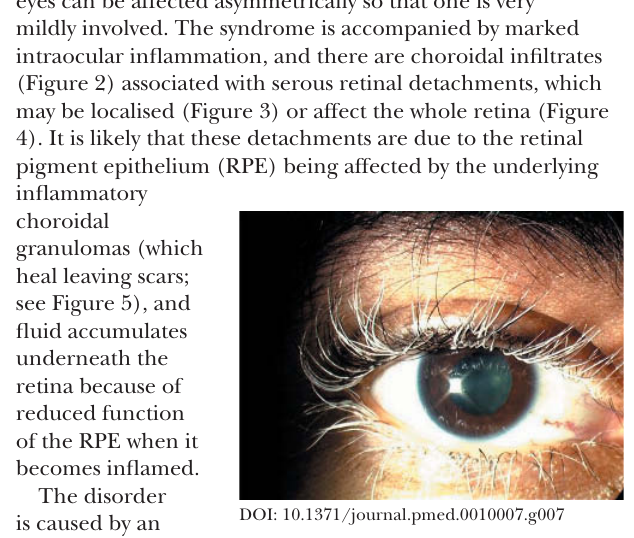
Figure 7. Poliosis Note white eyelashes on child.